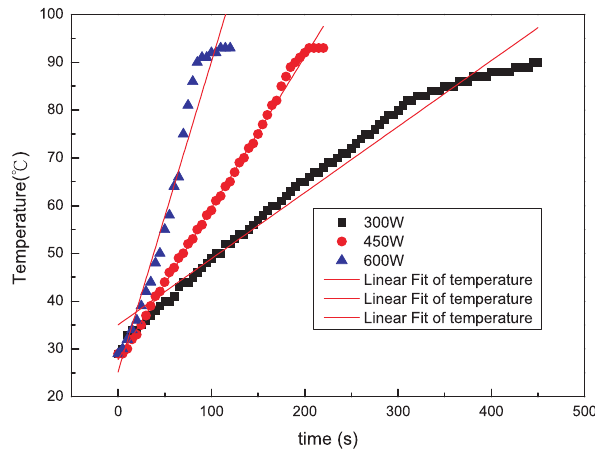
Fig. 11: Increase in sample temperature with microwave heating time when heated at power levels of 300 W, 450 W and 600